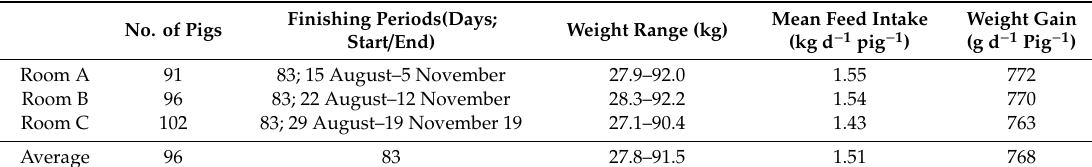
weight gain of the pigs in Rooms A to C. The average feed conversion efficiency was calculated to be 1.97 kg/kg.